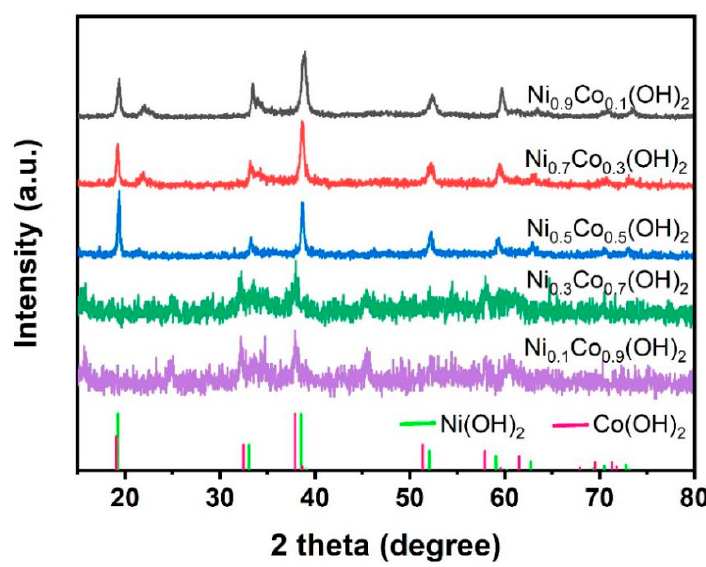
Figure 2. X-ray powder diffraction (XRD) patterns of the Ni 1-x Co x (OH) 2 .